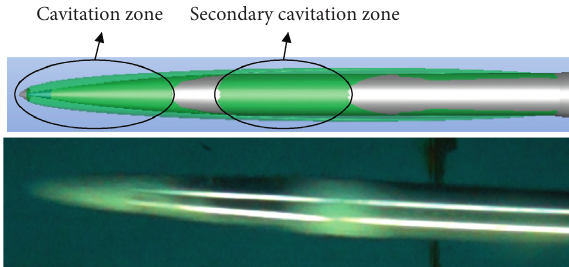
Figure 9: Secondary cavitation from CFD and experiments.